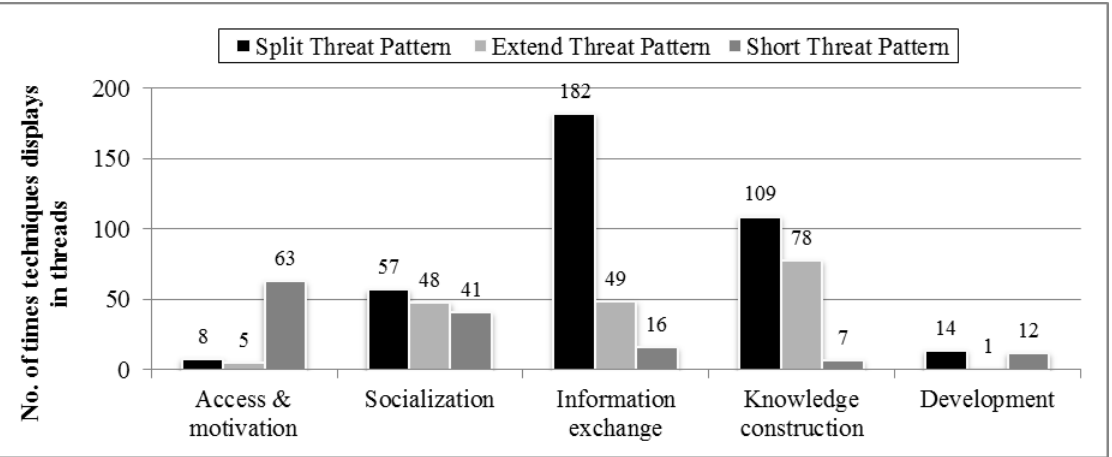
Figure 3. Percentages of the occurrence of the five levels of e-moderating support per thread patterns.